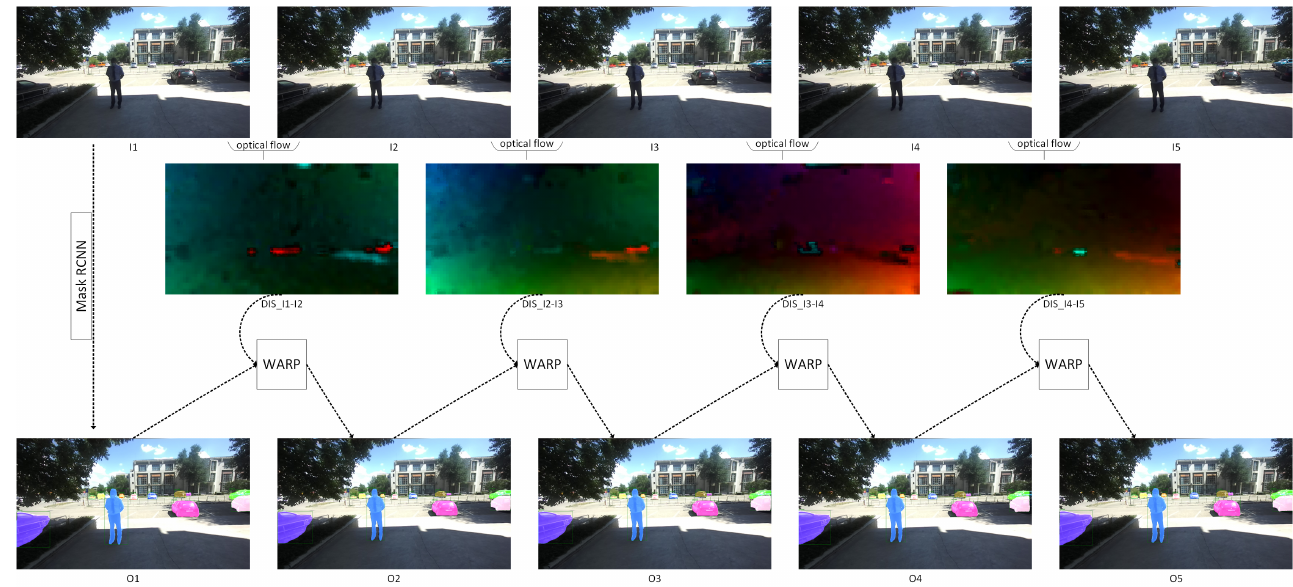
Figure A1. Framework results—our dataset (1): I x —input image x , DIS _ I x − I y —optical flow (DIS_ultrafast) between I x and I y , O x —output image